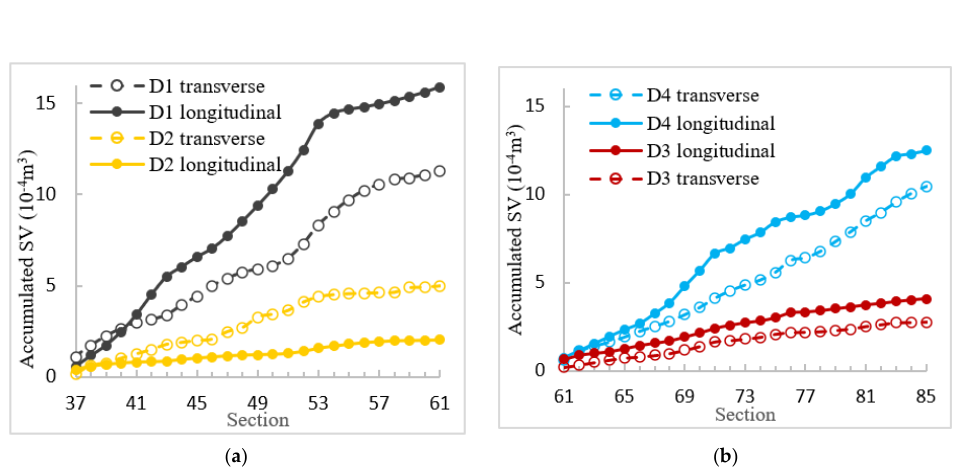
Figure 4. Accumulated SV of the colored grains ( a ) along the B 2 bend of the 110° flume; ( b ) along the B 3 bend of the 110° flume.